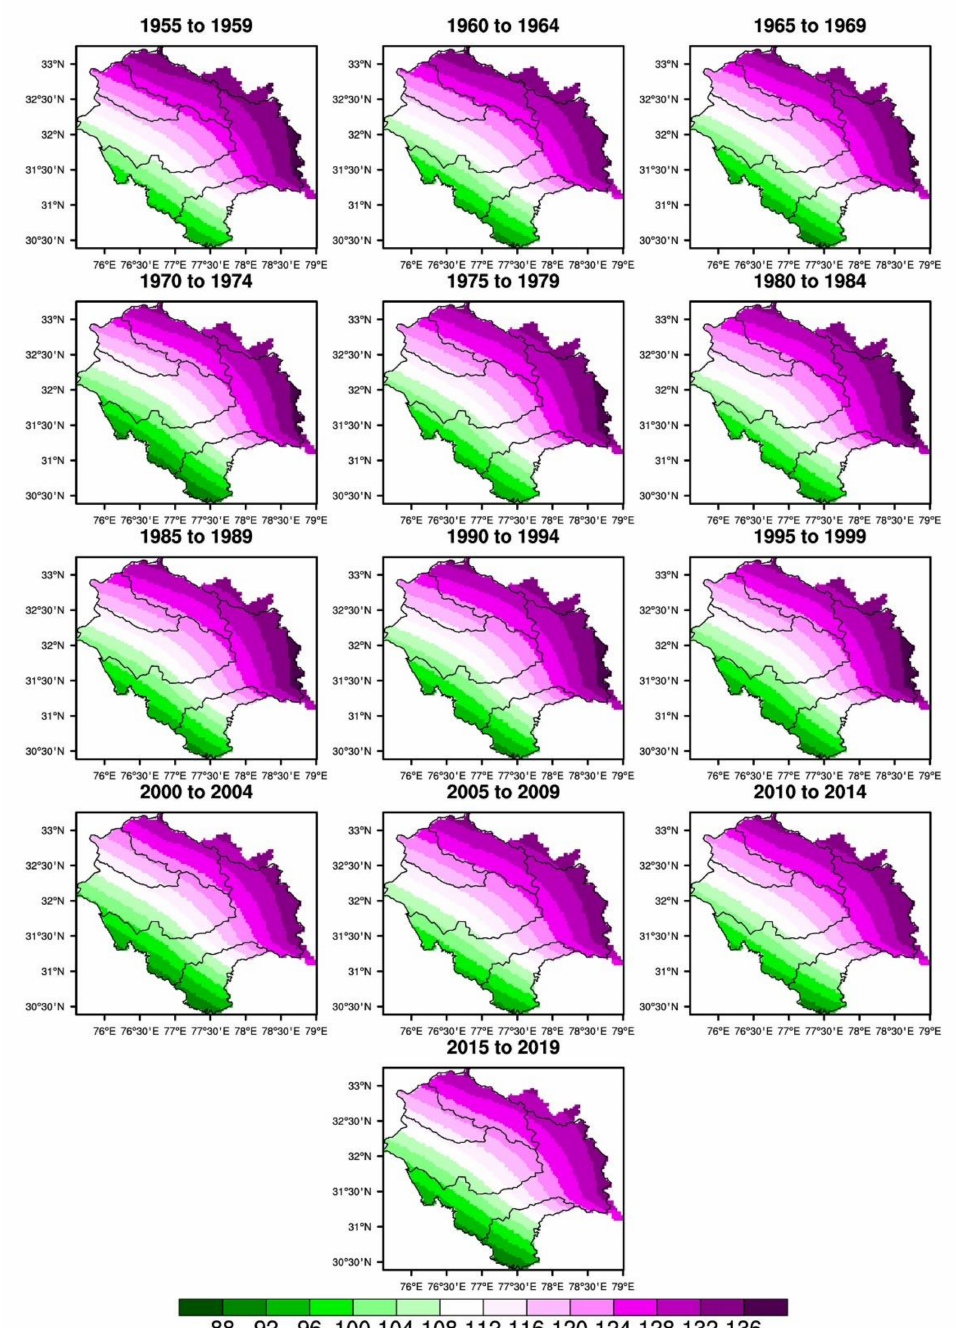
Figure 5. Pentads showing total annual soil moisture in five river basins of the Himachal Pradesh. Each pentad shows the mean of the five years from 1955 to